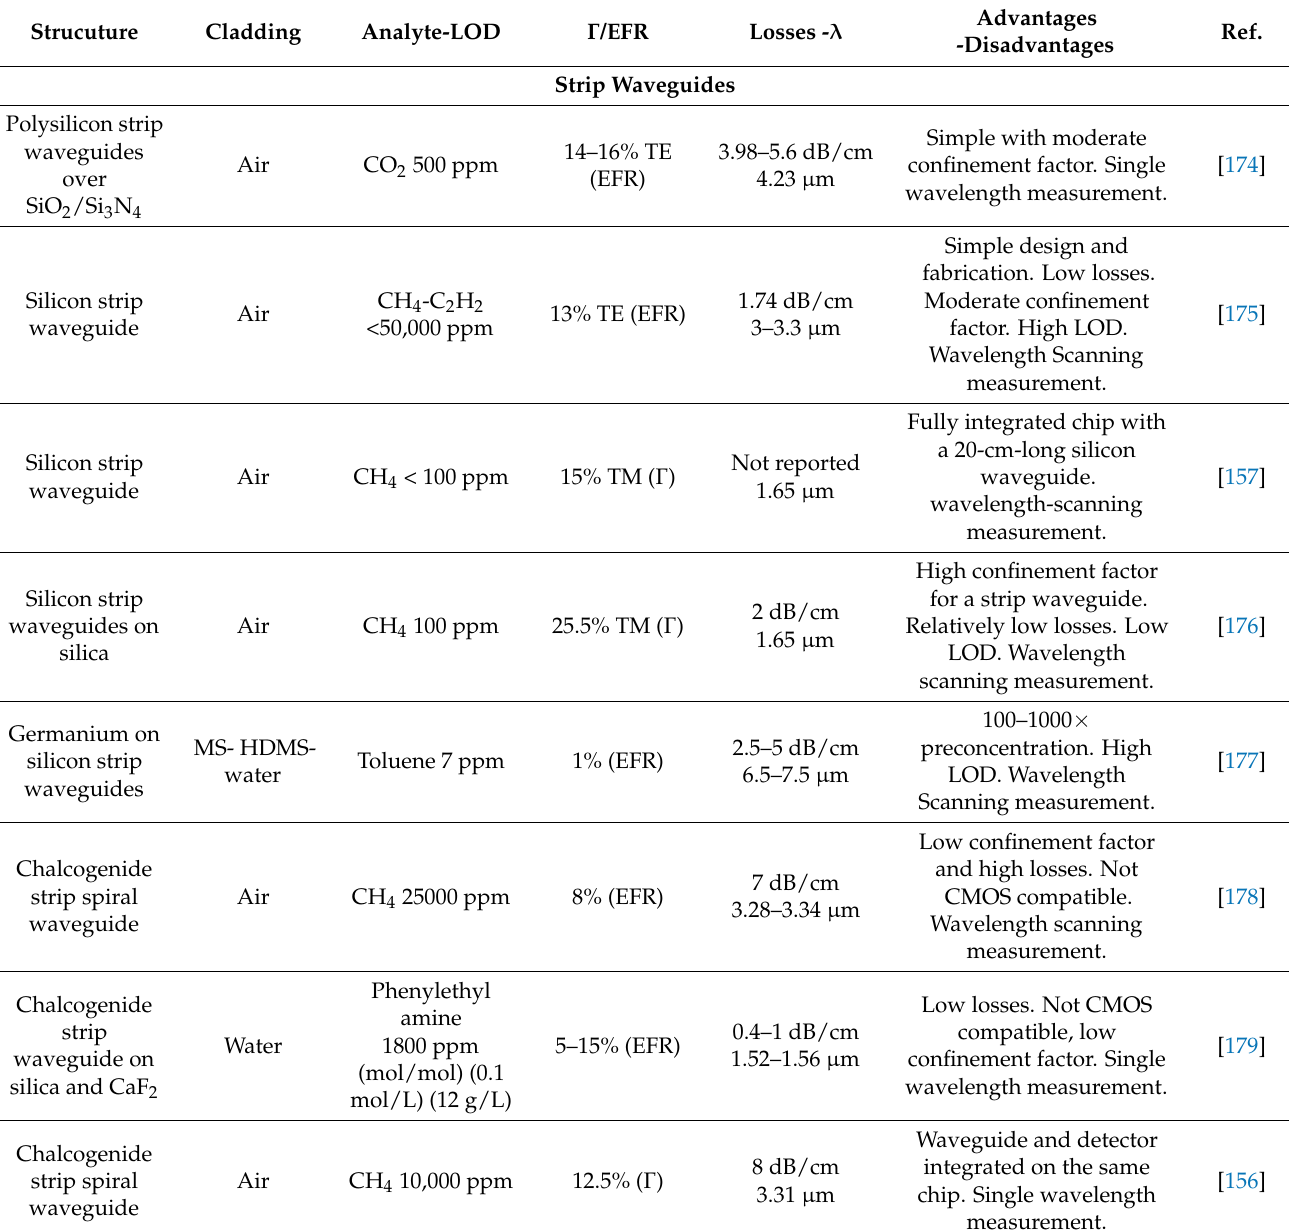
Table 1. Overview of works using WIRAS for gas